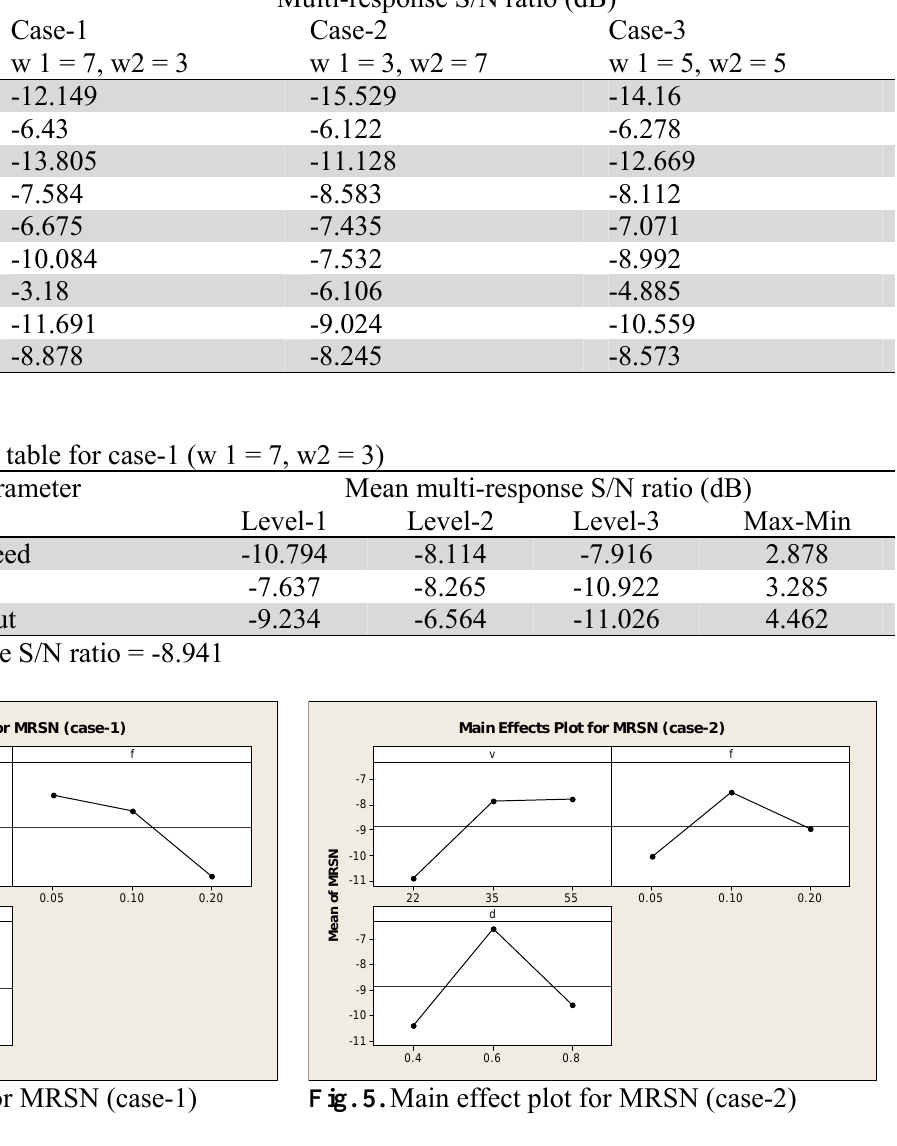
Multi-response S/N ratio (MRSN) with different weighting factors Experiment No.